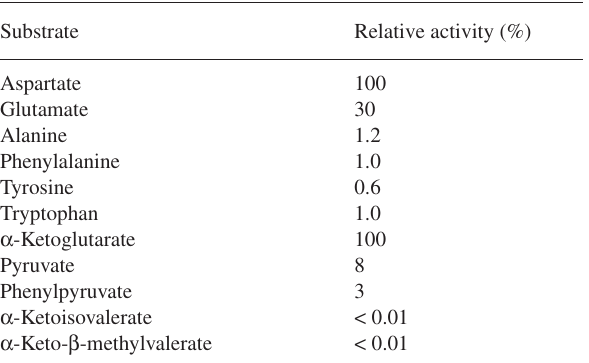
Table 2. Substrate specificity of rAspAT from P . furiosus . The amino acids (20 mM) were assayed with 5 mM α -ketoglutarate as the amino acceptor, and the α -ketoacids (5 mM) were assayed with 20 mM aspartate as the amino donor.